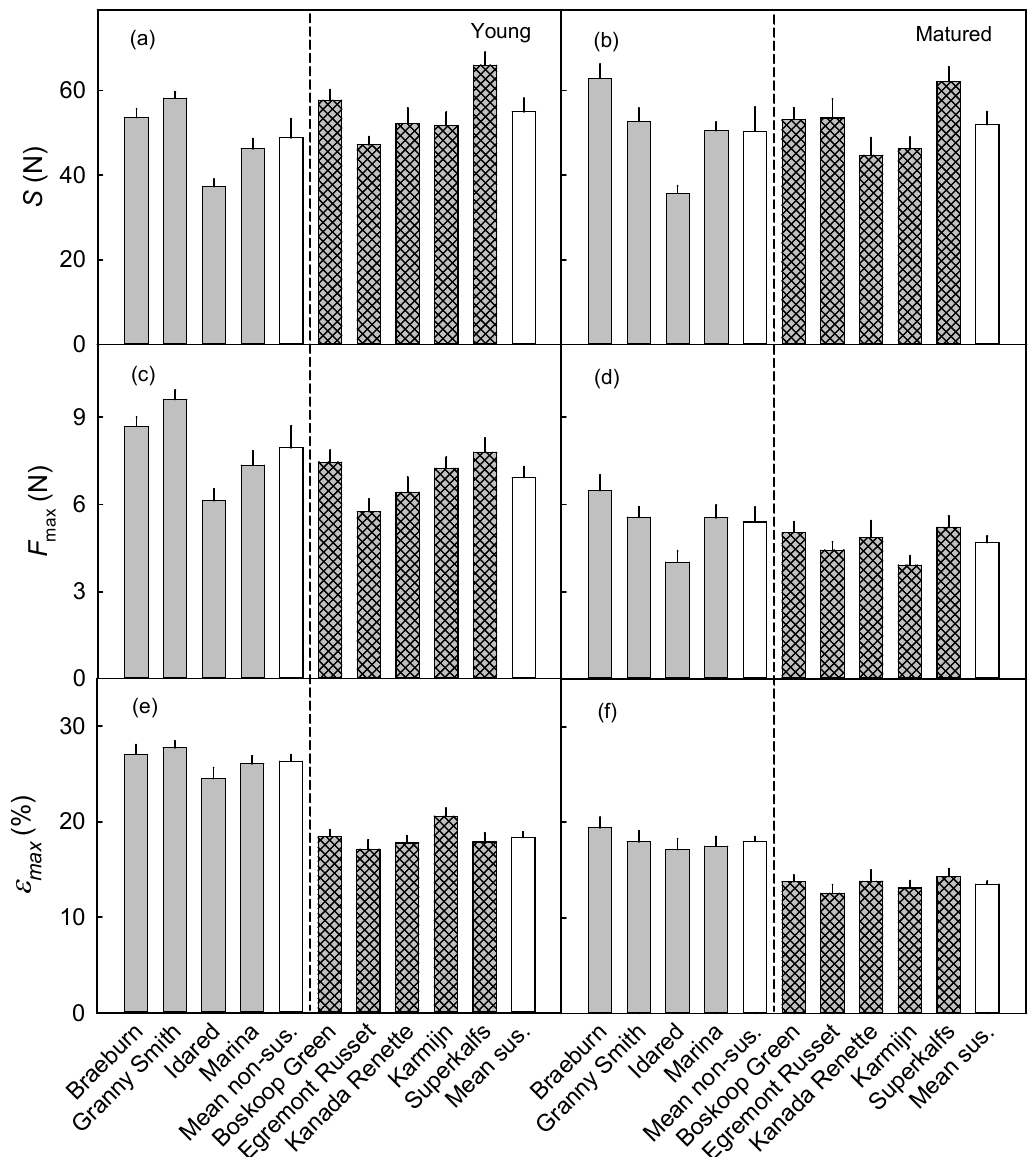
Figure 7. Sti ff ness ( S ; a , b ), maximum force ( F max ; c , d ), and maximum strain ( ε max ; e , f ) of exocarp segments (ES) of 0.5 mm standard thickness excised from young (49–56 days after full bloom) ( a , c , e ) and mature ( b , d , f ) fruit of selected apple cultivars belonging to russet non-susceptible ( left ) and russet-susceptible ( right ) groups (separated by a vertical dashed line). Mean non-sus. and Mean sus. represent the mean of russet non-susceptible and russet susceptible groups, respectively. The numbers of replicates were 20–29 (young) and 15–24